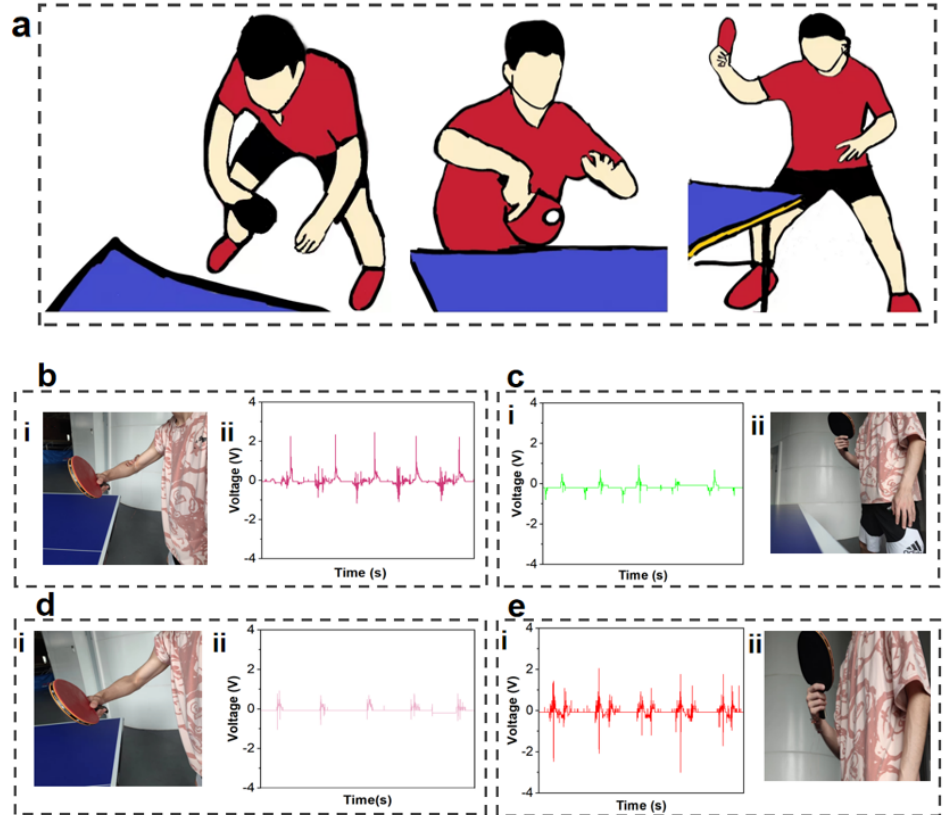
Figure 4. Application of LS ‐ TENG in backhand loop technique. ( a ) Schematic diagram of backhand loop technique. ( b ) Elbow state and output voltage of standard backhand loop technical action. (i) Elbow state diagram of standard backhand loop technical action. (ii) The output voltage of the